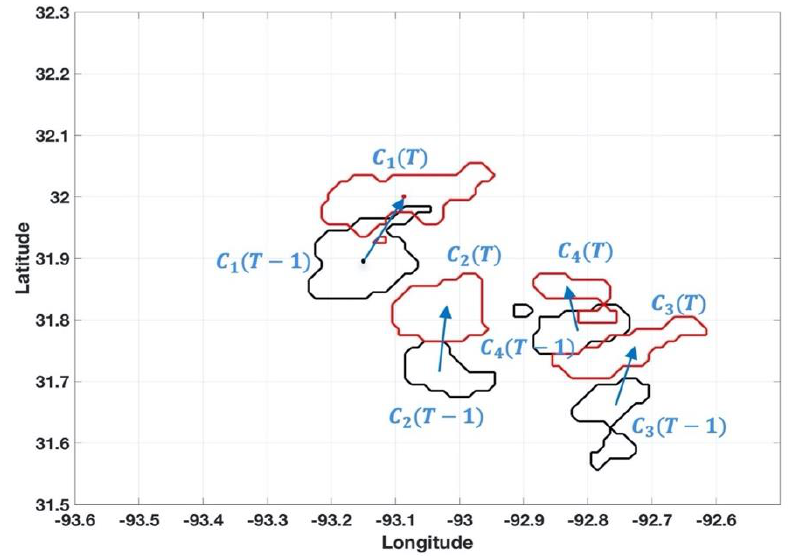
Figure 5. Motion vectors from four cells ( C 1 , C 2 , C 3 , and C 4 ).